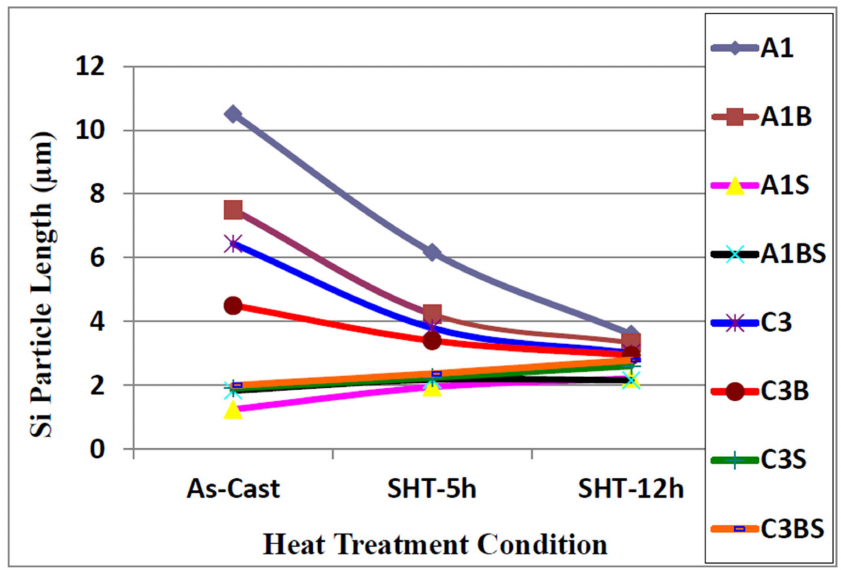
Figure 5. Variation in particle length of eutectic silicon as a function of heat treatment condition, DAS ~ 25 µ